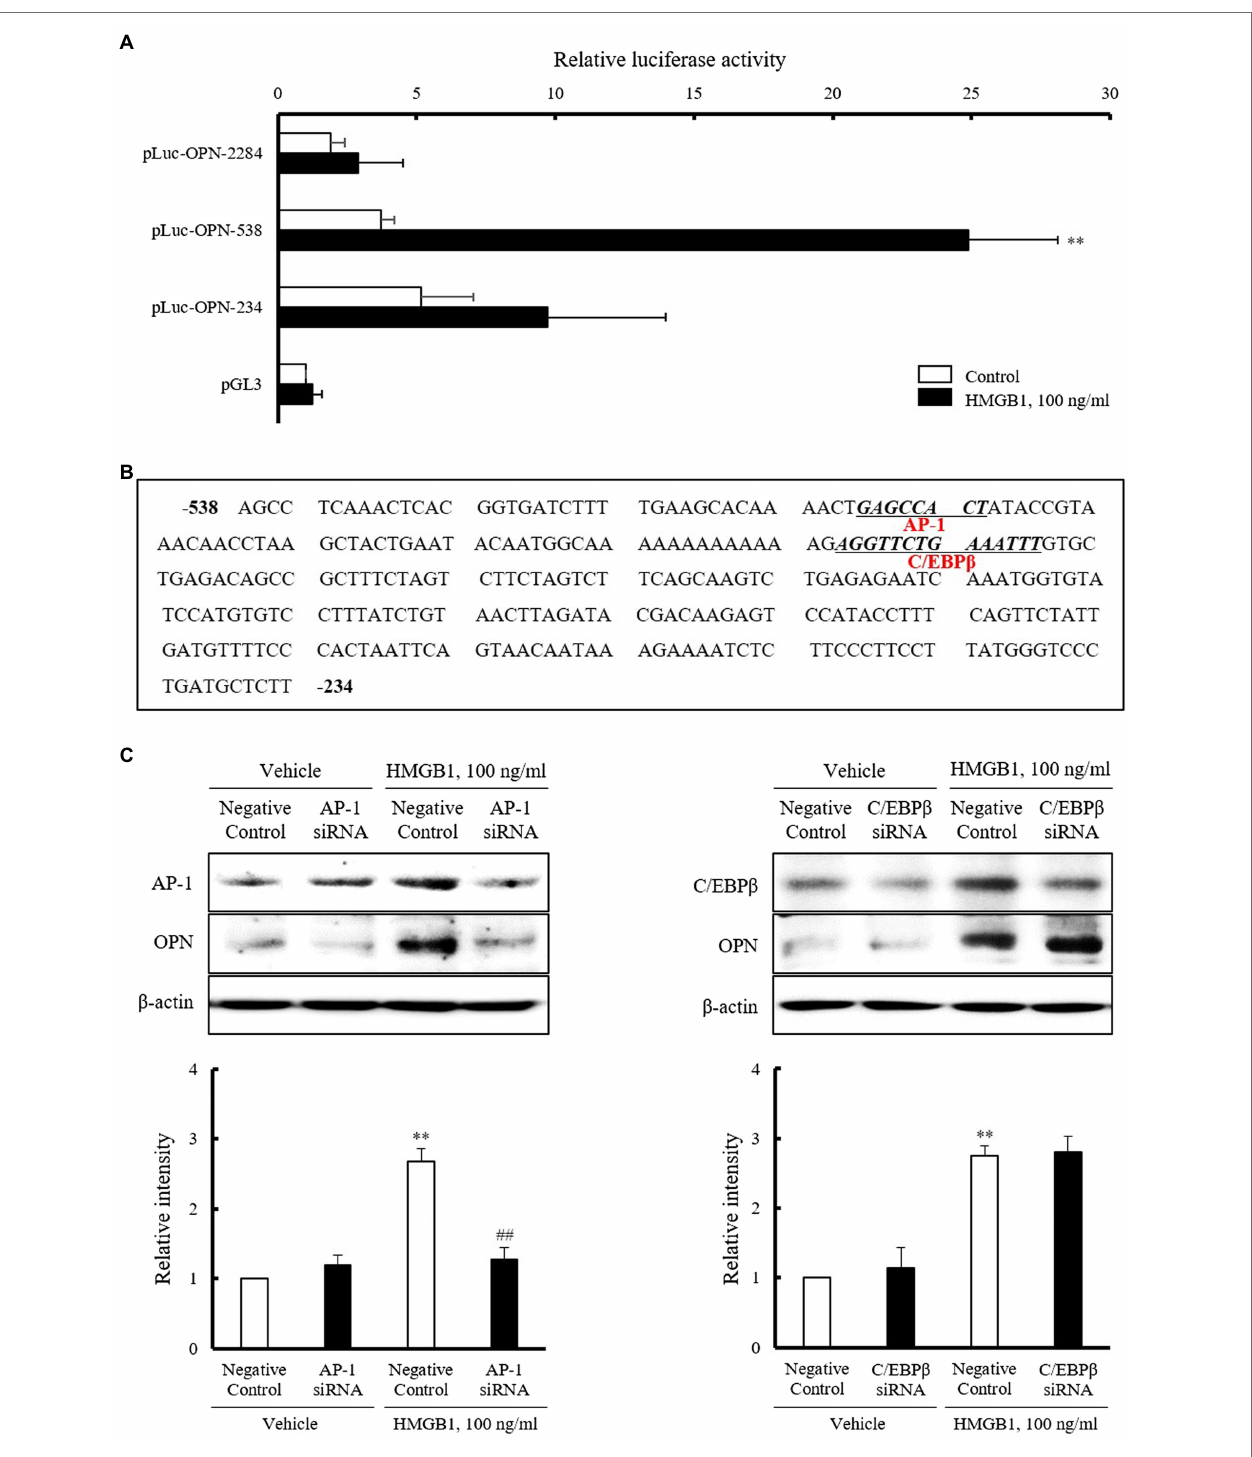
FIGURE 4 | Identification of the transcription factors mediating OPN expression in HMGB1-stimulated VSMCs. (A) VSMCs were transfected with various promoter constructs or an empty luciferase vector (pGL3) for 48 h and then stimulated with HMGB1 (100 ng/ml) for 3 h. Relative luciferase activities were expressed as the mean ± SEM of four independent experiments. ** p < 0.01 vs. corresponding value in control. (B) Nucleotide sequence of the –538 ~ –234 promoter region of the OPN gene is shown. The sequence of potential binding sites for AP-1 and C/EBP β in pLuc-OPN-538 were underlined. The transcription factor-binding sites were identified using TF search software. (C) VSMCs were transfected with AP-1 and C/EBP β siRNAs (200 nM) for 48 h and then stimulated with HMGB1 (100 ng/ml) for 48 h. The expression of OPN was determined by Western blot. β -actin was used as a control. Relative intensities were expressed as the mean ± SEM of five independent experiments. ** p < 0.01 vs. corresponding value in negative control in vehicle and ## p < 0.01 vs. value in negative control in